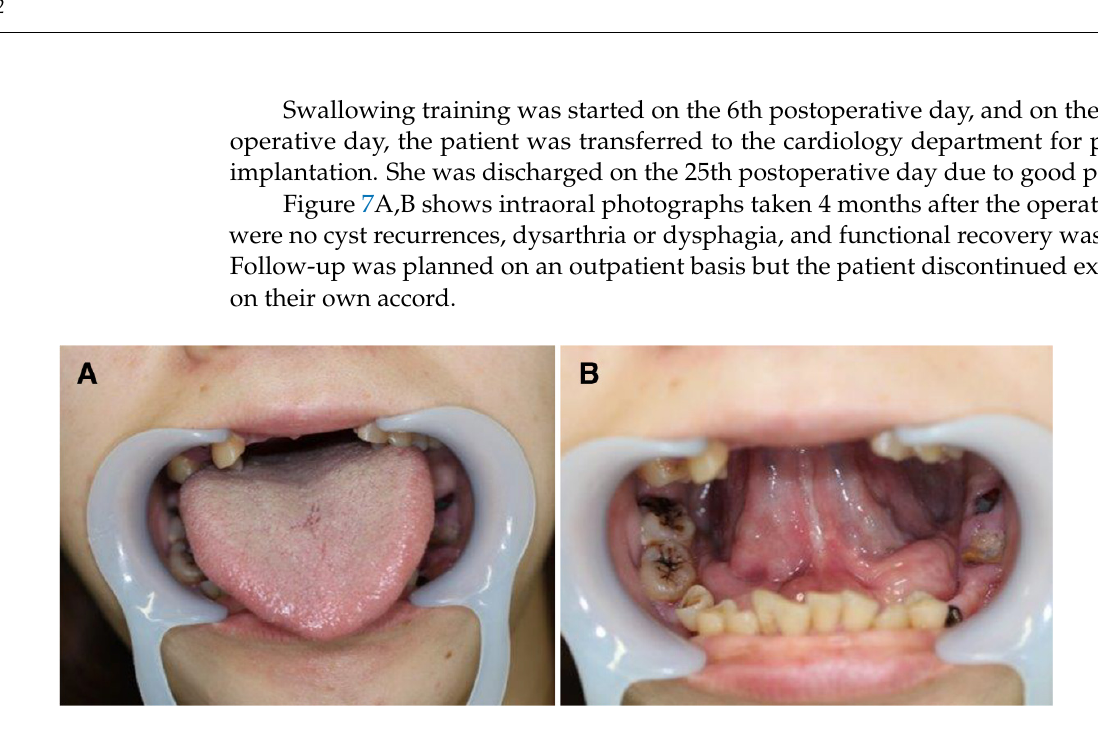
Figure 7. ( A , B ) Four months after surgery. Swallowing function and articulation function improved and the course was good.